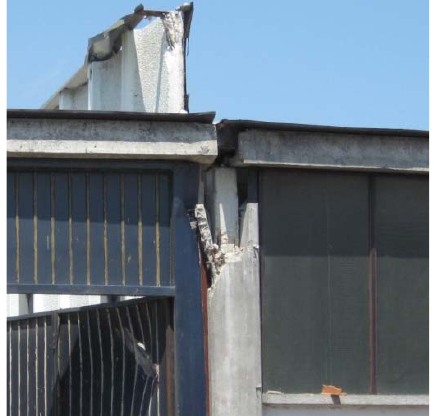
Figure 9. U-shaped seat damaged by twisted roof beam.